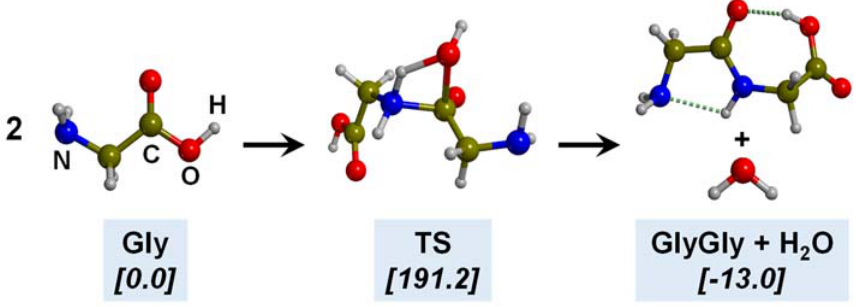
Figure 7. Reaction mechanism of the peptide bond formation between two Gly molecules. TS is the transition state connecting Gly with Gly Gly. Values in brackets refer to the energetics of the process in kJ mol − 1 .